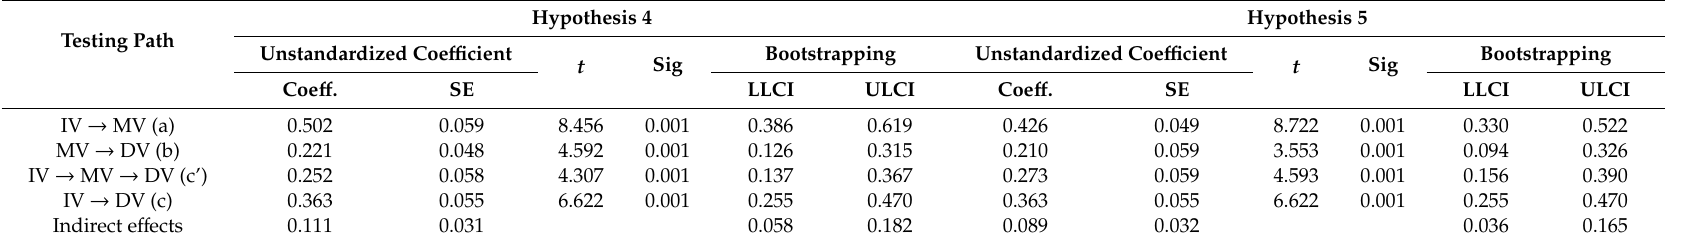
Table 5. Coe ffi cients for mediating e ff ects.